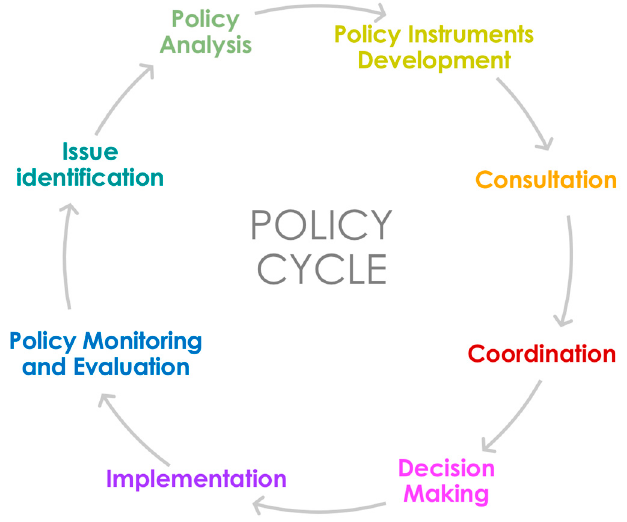
Figure 3. The policy cycle (source: adapted from ref.[56]).